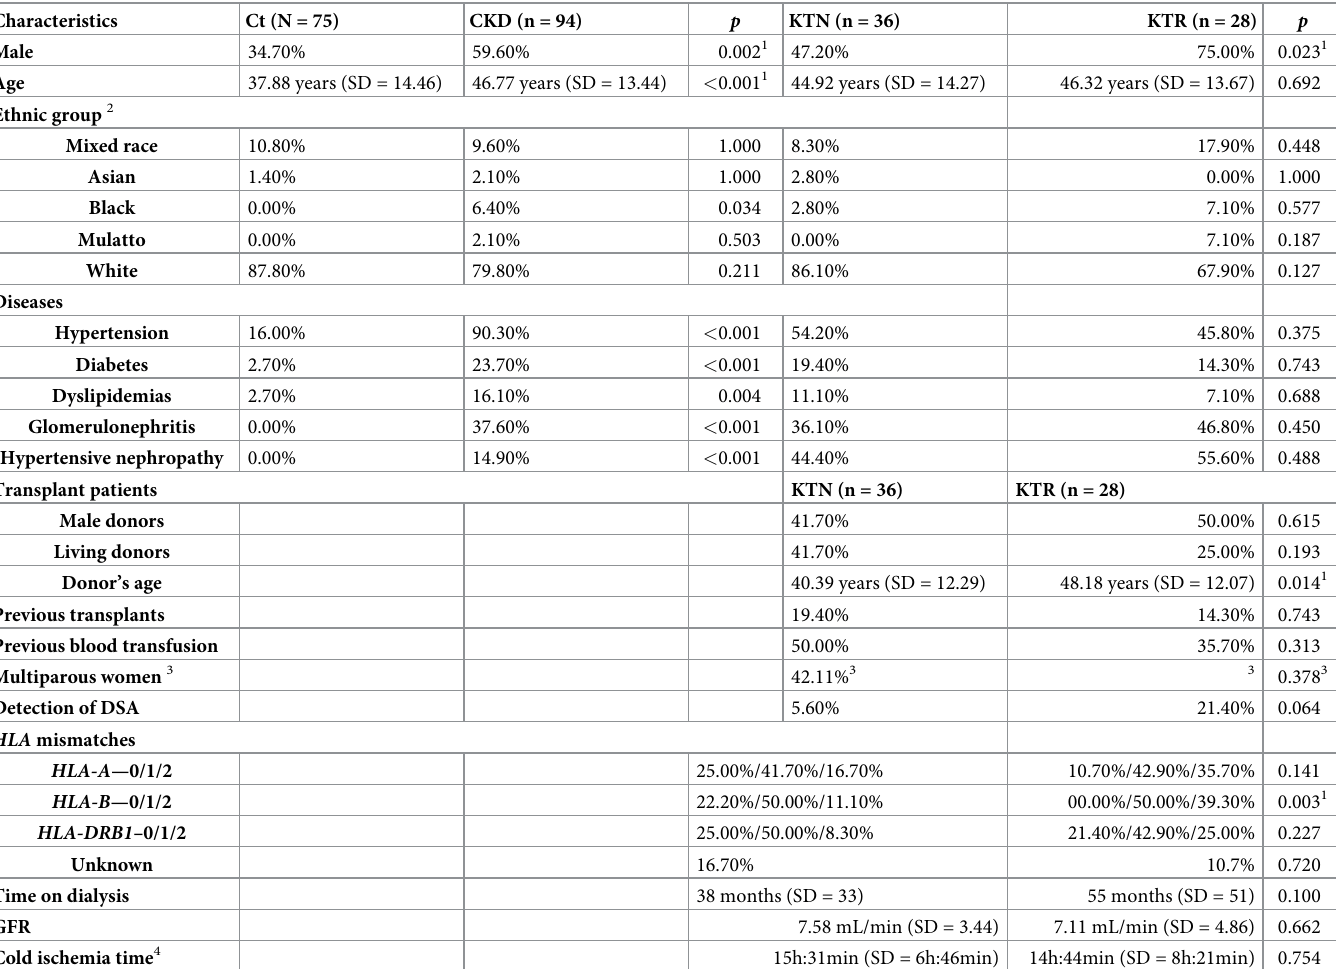
Table 1. Demographic characterization of the sample.